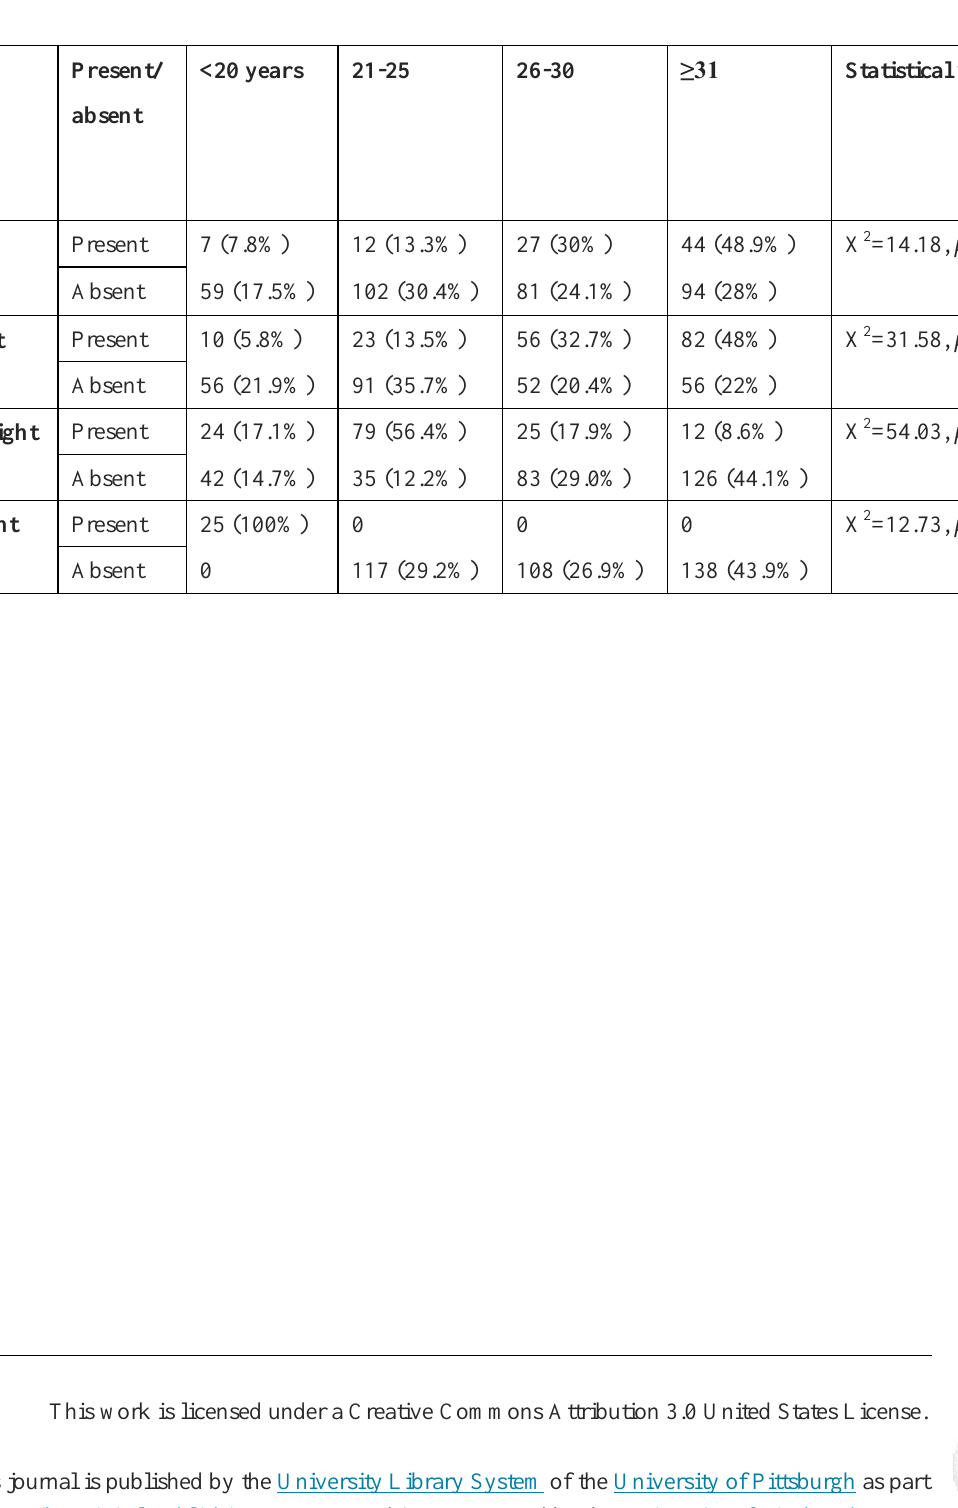
Table 3: Distribution of respondents according to the presence or absence of specific weight